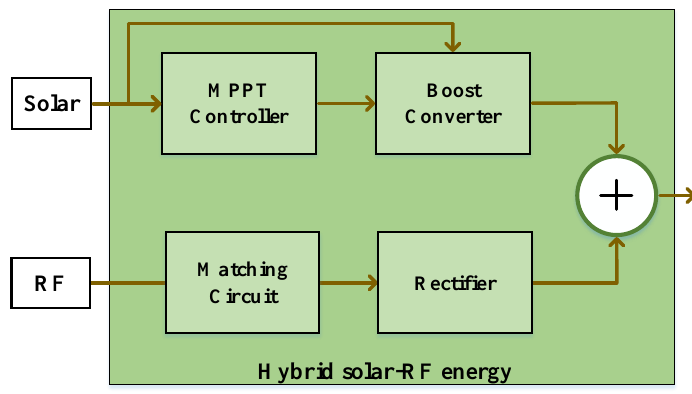
Figure 2. The block diagram of hybrid solar-RF energy system.